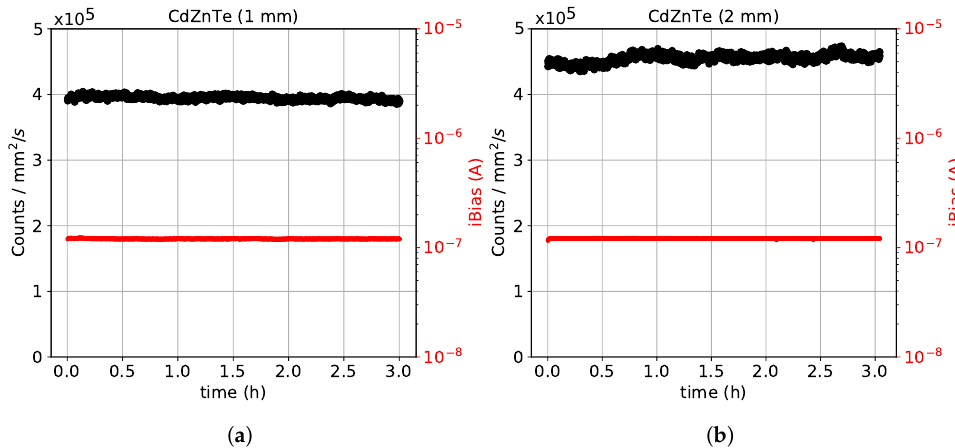
Figure 10. Monitoring of the count rate (in black) and the total leakage current (in red) over irradiation time for CdZnTe sensors of 55 µm pixel pitch and a thickness of ( a ) 1 mm and ( b ) 2 mm. The energy threshold was set at half of the characteristic energy of Source